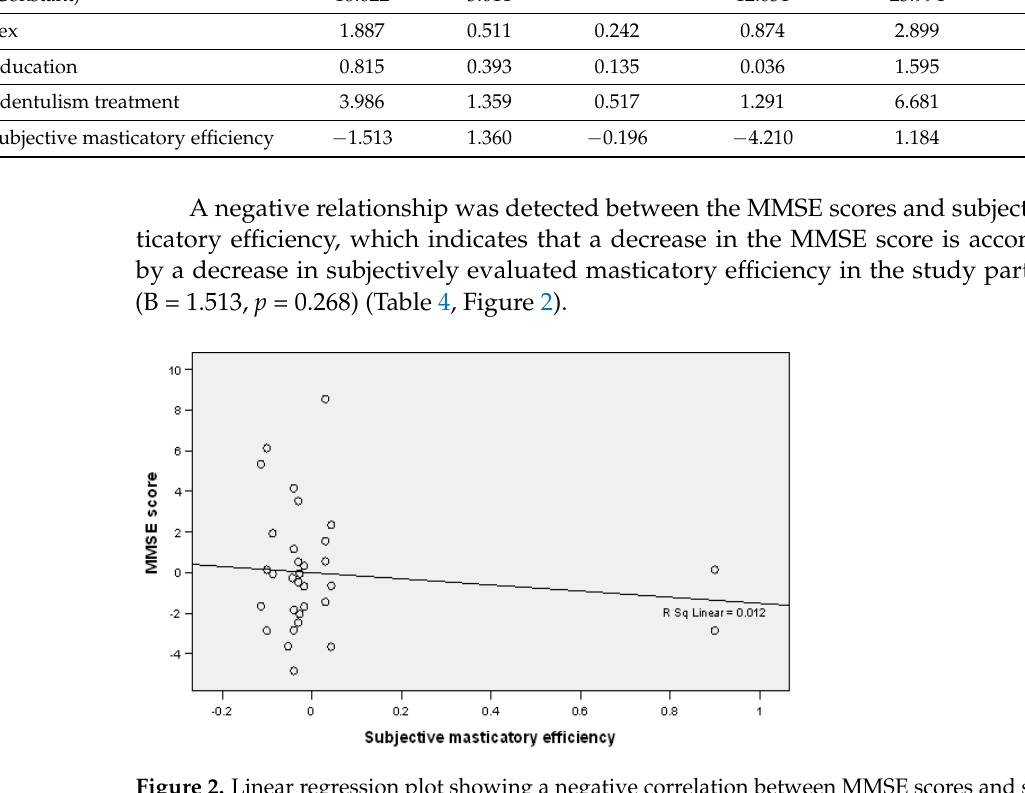
Figure 2. Linear regression plot showing a negative correlation between MMSE scores and subjective masticatory efficiency.